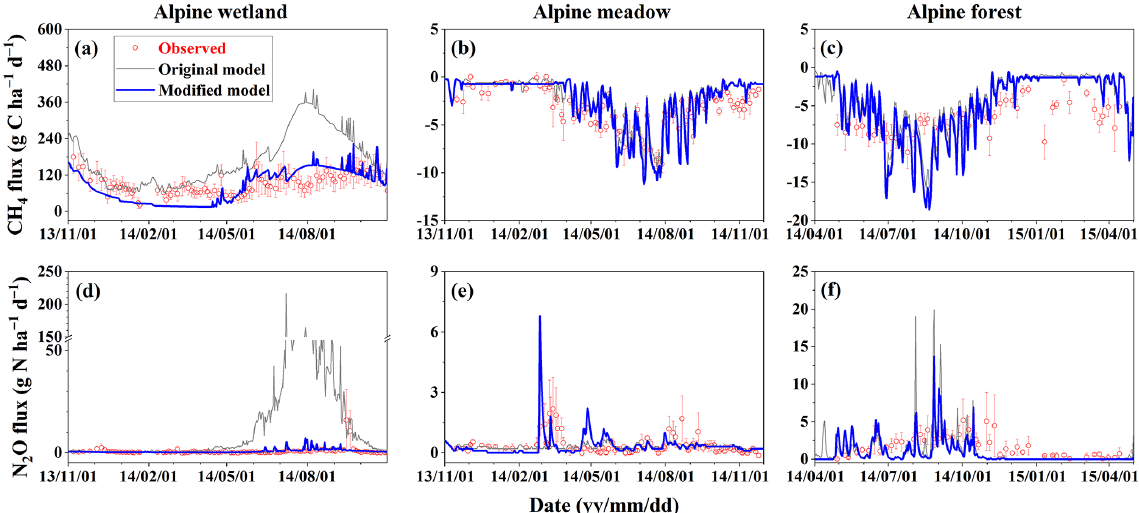
Figure 3. Observed and simulated daily methane (CH 4 ) and nitrous oxide (N 2 O) fluxes from the alpine wetlands, meadows and forests by the original and modified models. The vertical bar for each observation indicates the standard error of six spatial replicates. The legend in panel (a) applies for all panels.